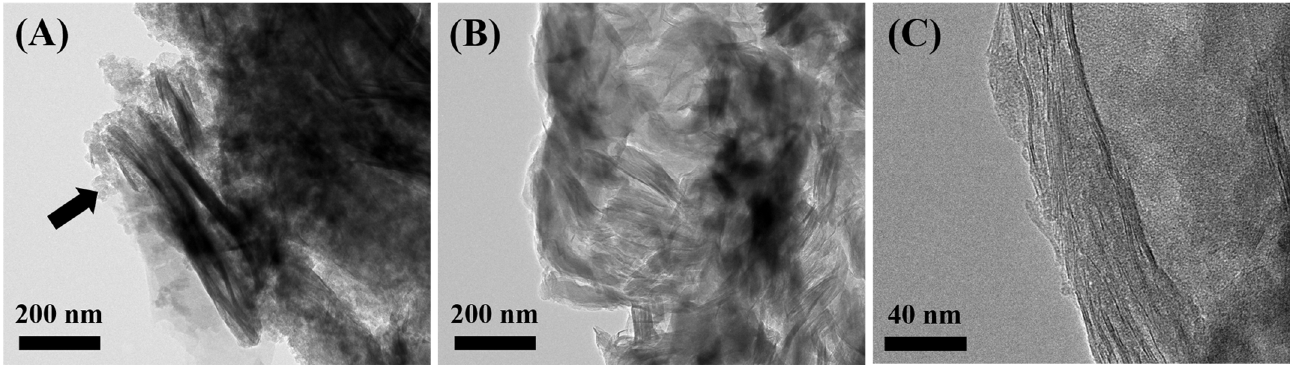
Figure 3. Transmittance electron microscopy images of ( A ) powdered Alg-PCH; ( B , C ) sectioned Alg-PCH fixed with Spurr’s resin.